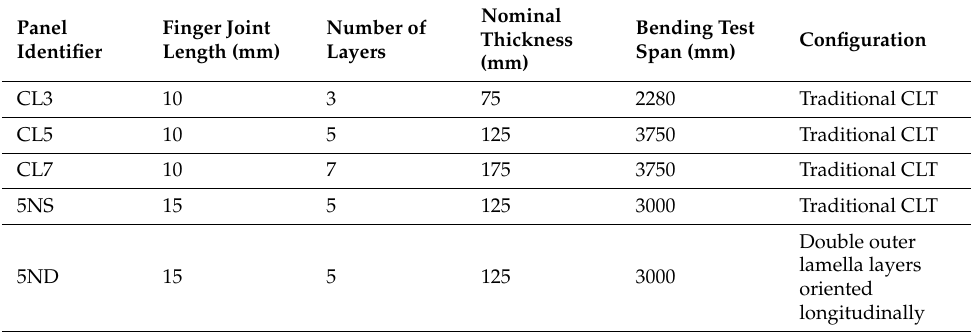
Table 1. Manufactured CLT panels’